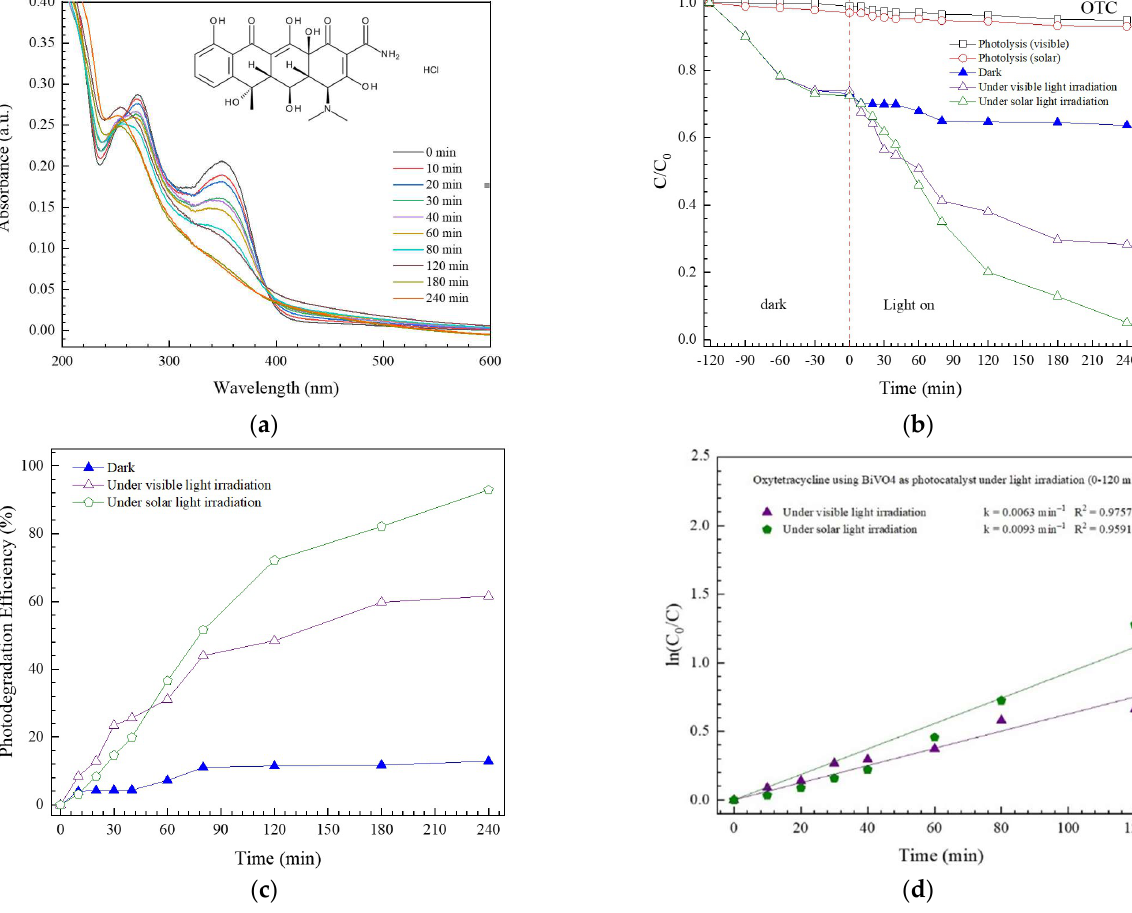
Figure 7. Lowering of absorbance with time toward photodegradation of OTC ( a ), decrease of C/C 0 with time ( b ), photodegradation efficiency ( c ), and determination of rate constant ( d ).